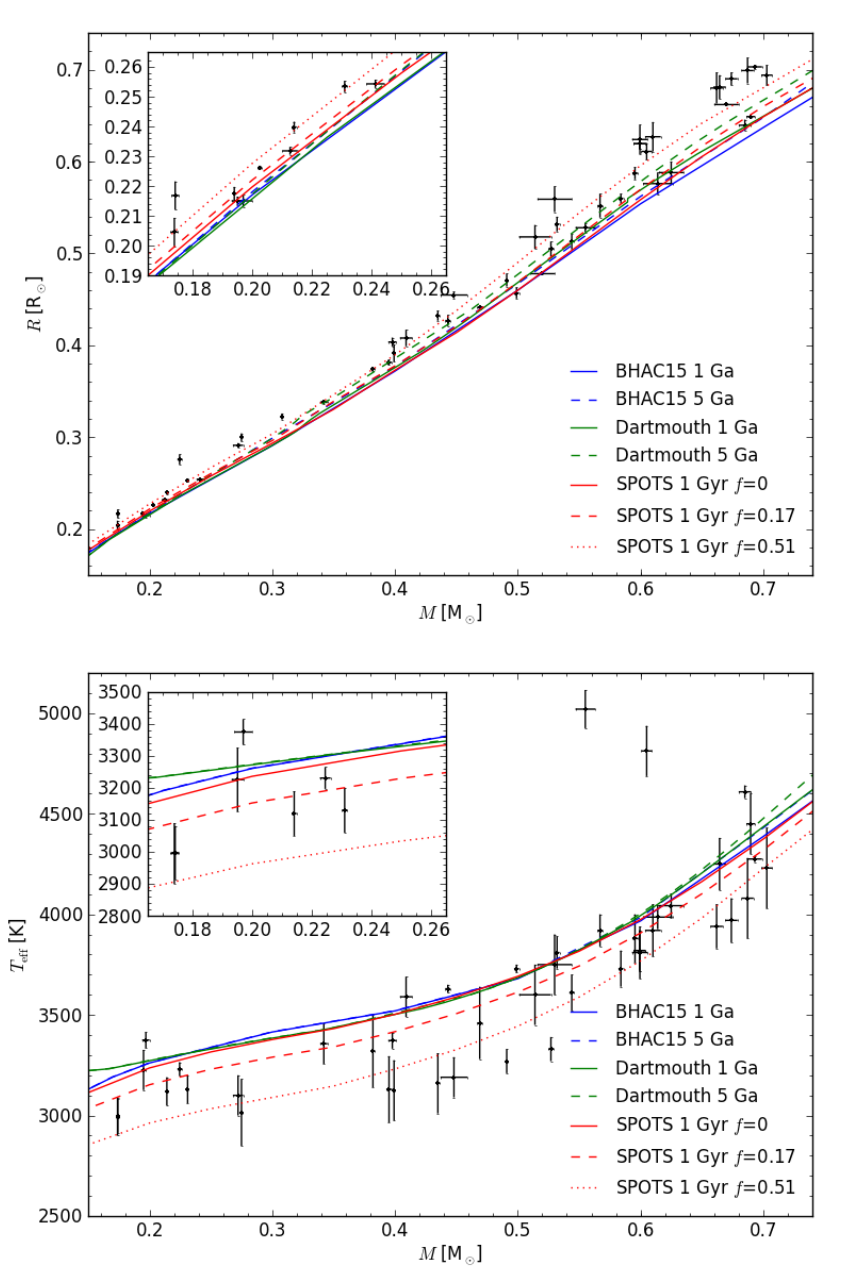
Figure 1. M − R ( top ) and M − T eff ( bottom ) relationships for the late-type stars listed in Table1. BHAC15, Darmouth, and SPOTS stellar models with different parameters are plotted as labeled. Inset plots show a zoom in into the lower mass